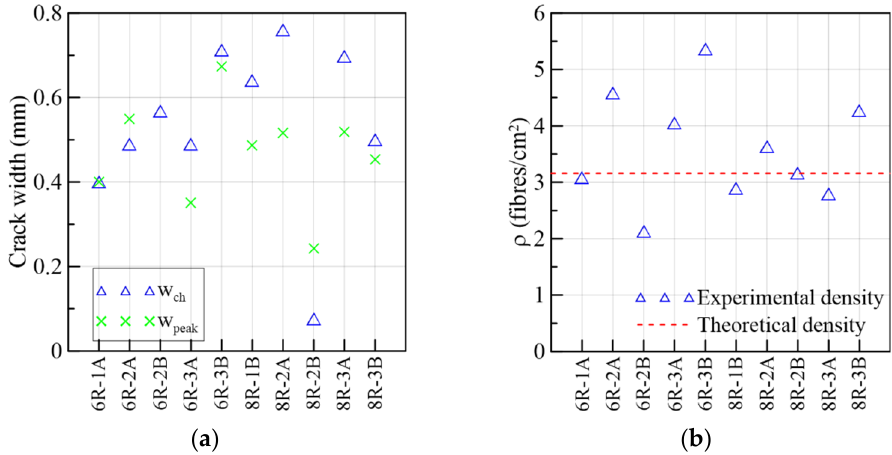
Figure 16. Mechanical results of 6R and 8R specimens: ( a ) crack widths at change in behavior and at peak load and ( b ) fiber densities.